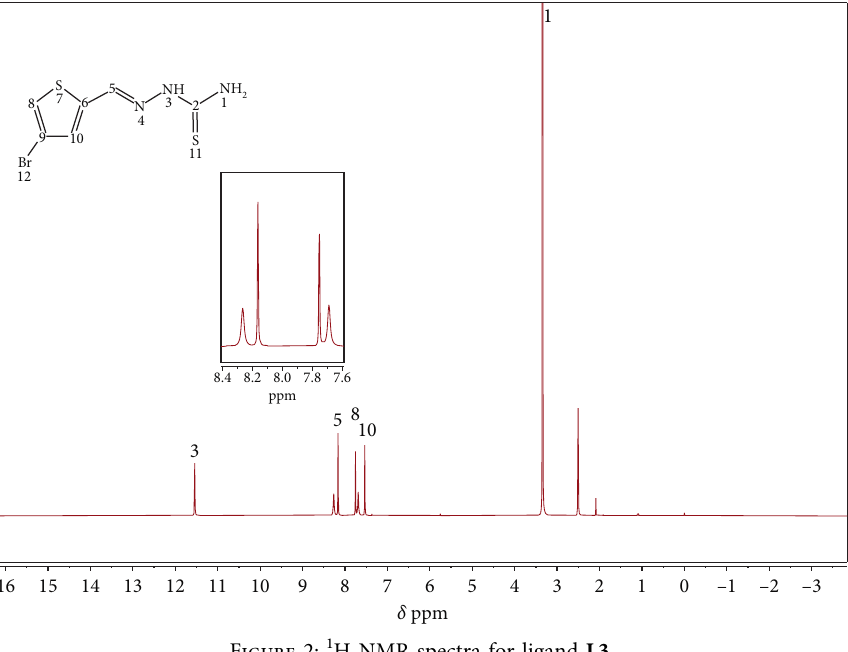
Figure 2: 1 H-NMR spectra for ligand L3 .